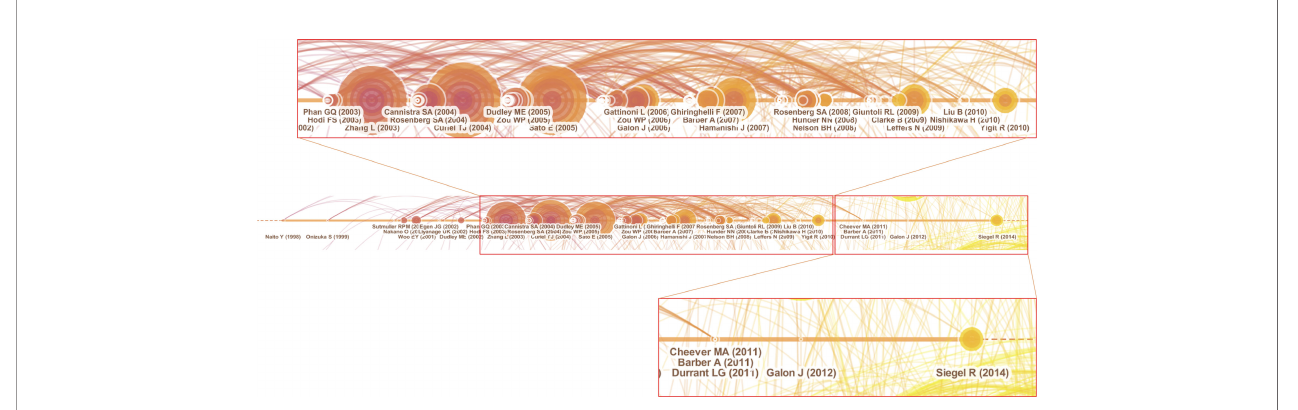
FIGURE 7 | High impact members in cluster #1.